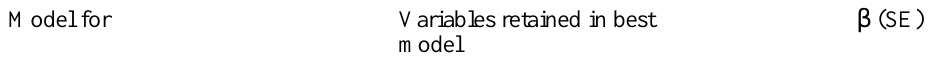
Table 3. Model coefficients with standard errors in parentheses for variables retained in final models (Table 2) for abundance, occupancy, and reproductive activity of Bobolink, Savannah Sparrow, and Nelson’s Sharp-tailed Sparrow in Nova Scotia. Model notation follows Table